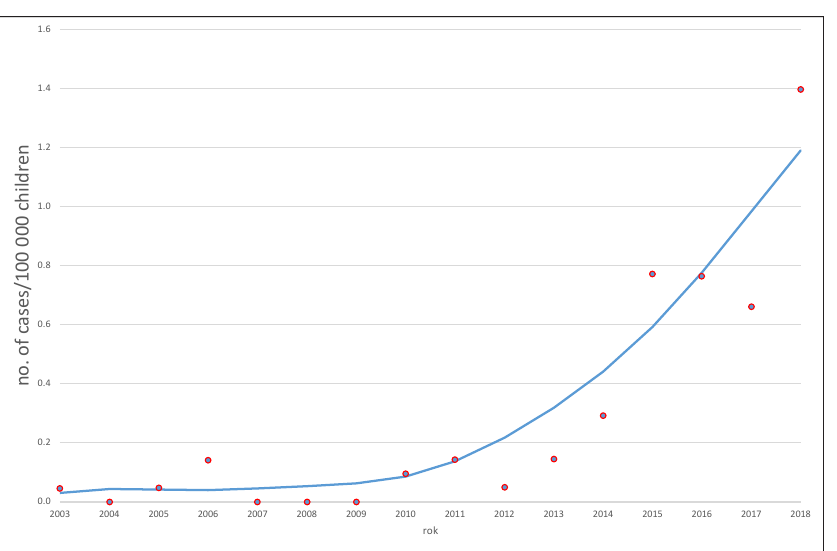
Fig. 1. Incidence of mycobacteriosis in the Czech Republic in the period 2003–2018.